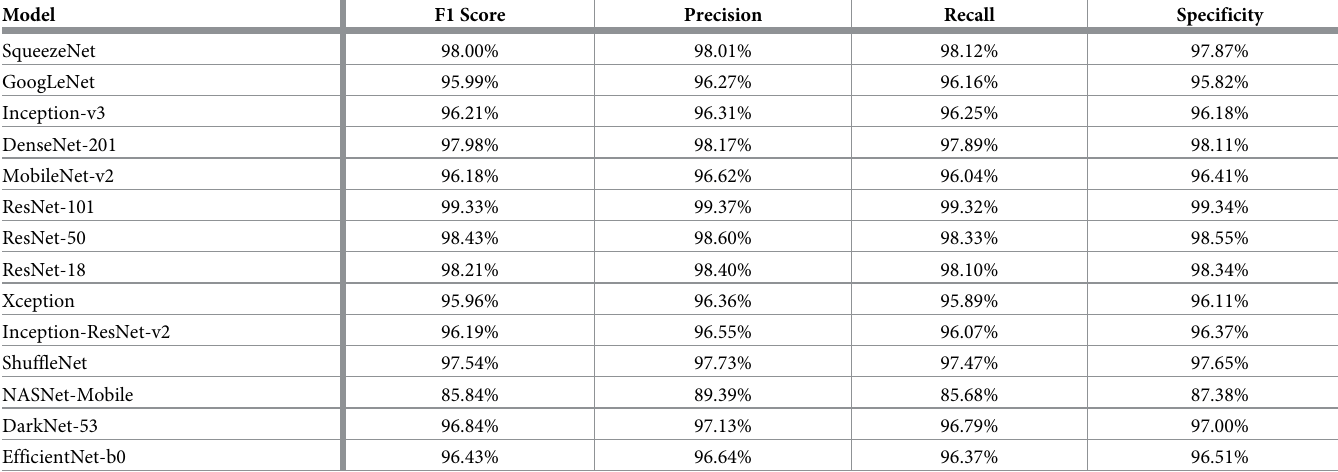
Table 6. The mean overall F1 score, precision, and recall parameters for the 14 deep learning models performing normal vs spondylolisthesis classification.